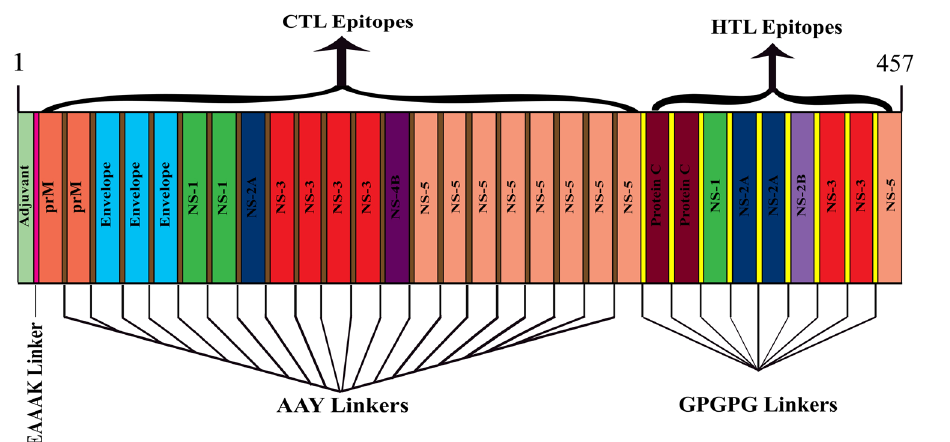
Figure 1. Schematic diagram of multi-epitope vaccine construct: A 457 amino acid long multi-epitope vaccine sequence consisting an adjuvant (green) at N-terminal end linked with a multi-epitope sequence with the help of EAAAK linker (pink). CTL epitopes were linked with the help of AAY linkers (brown) while HTL epitopes were fused with the help of GPGPG linkers